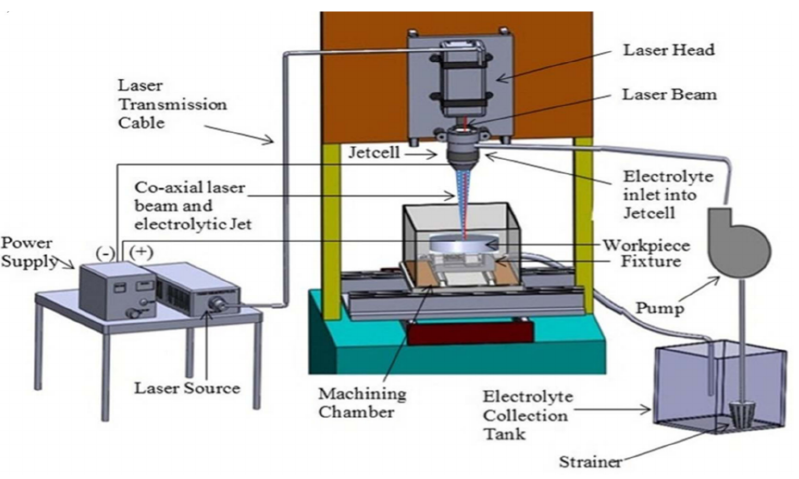
Figure 15. Schematic diagram of laser-assisted jet electrochemical machining (LA-JECM) [289] .